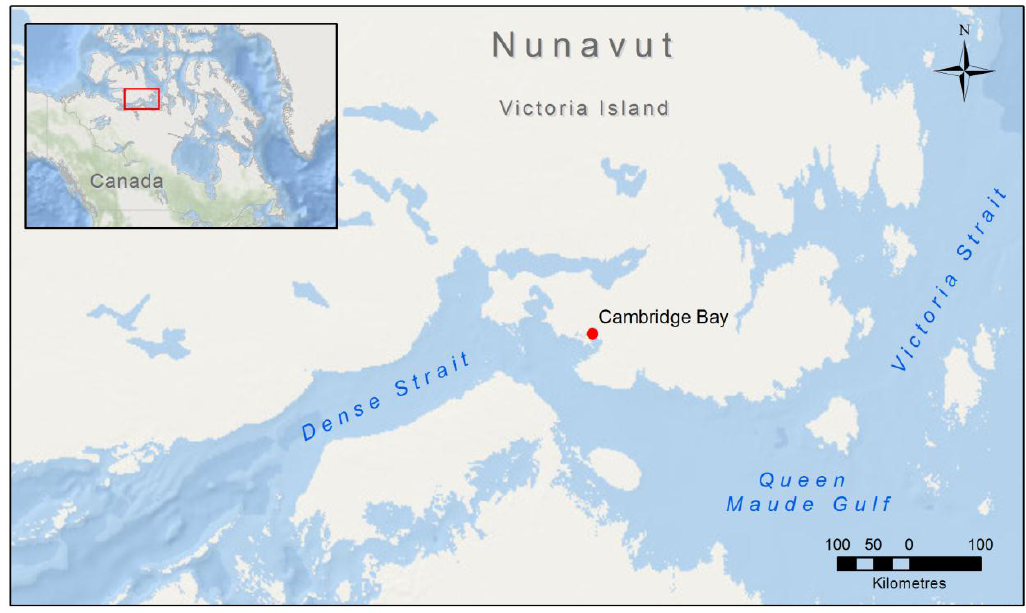
Figure 1. Cambridge Bay study area located in the Canadian Arctic on Victoria Island, Nunavut. Background map © ESRI.